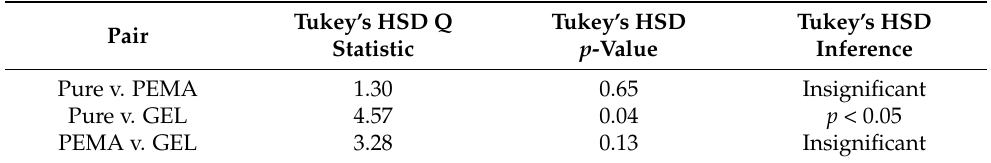
Table 5. Tukey’s statistical analysis for the measurement pairs, for Pure, PEMA and GEL samples initial scratches.